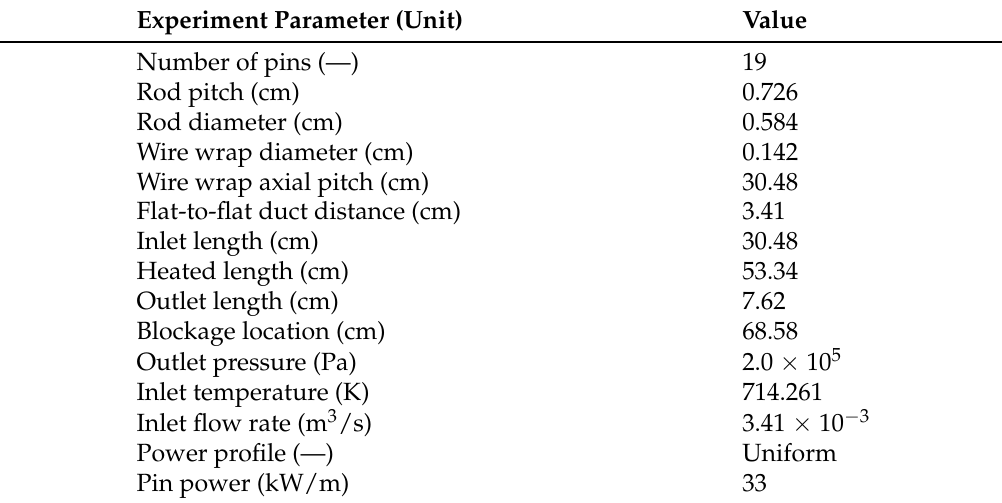
Table 8. Design and operational parameters for THORS six-channel blockage benchmark.